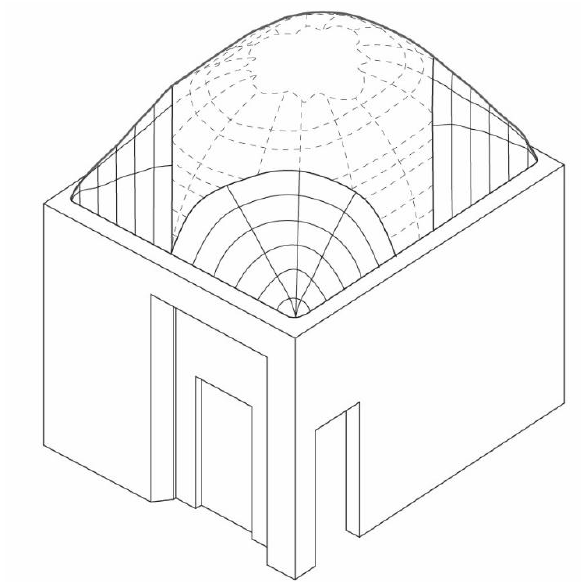
Figure 10. Axonometric view of vault slicing obtained by point cloud of intrados selected under the assumption of cone-shaped